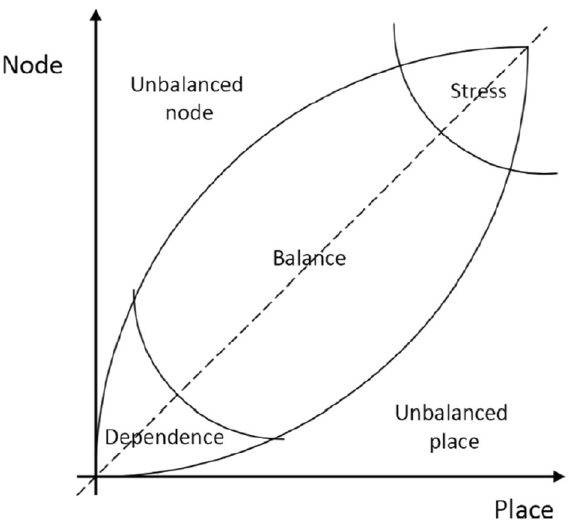
Figure 1. The Node-place model and five ideal–typical situations for a location 1